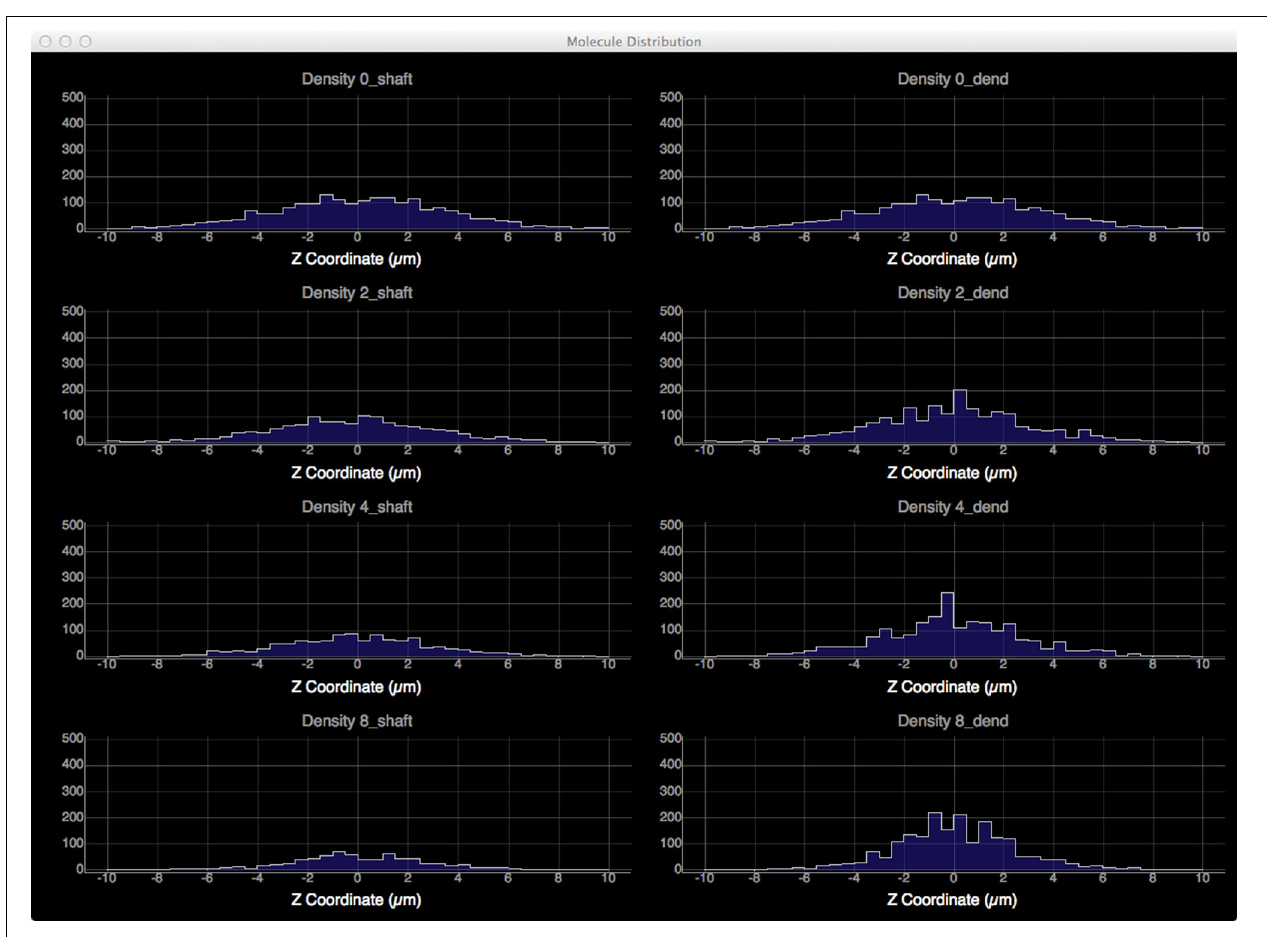
FIGURE 12 | Spatial distributions of molecules along dendritic shafts for simulations with varying spine densities (in top–down order: 0, 2, 4, 8 spines/ µ m). Left: distributions of molecules in the dendritic shafts. Right: